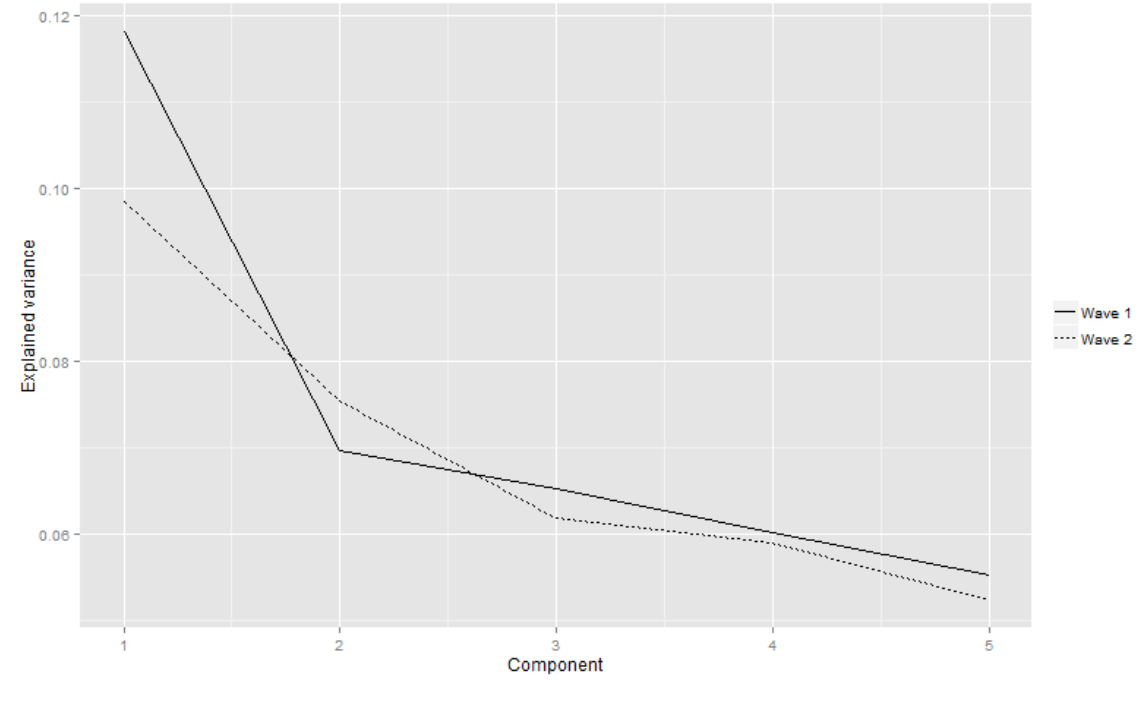
Figure 3: PCA: explained